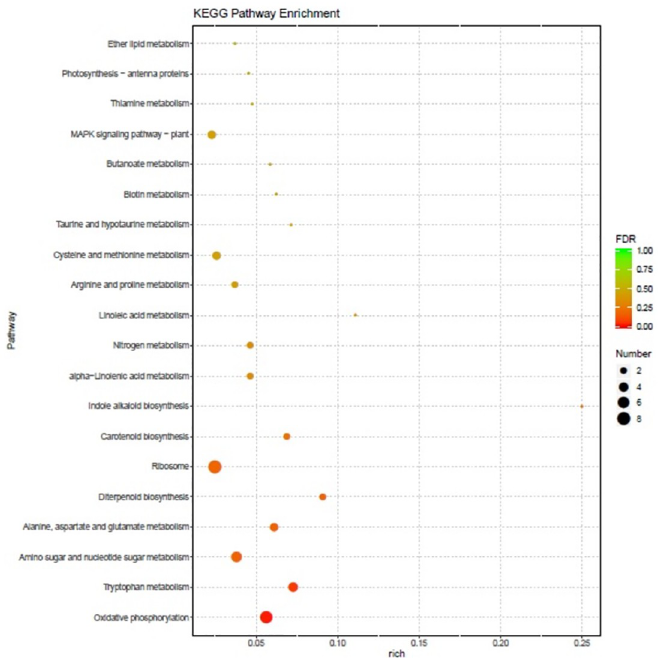
Fig 6. KEGG pathway analysis of differentially expressed genes during the B . aryabhattai -Arabidopsis interaction. The chart shows the enrichment of signaling pathways with differentially expressed genes. The Y-axis label represents the pathway, and the X-axis label represents the rich factor (rich factor = number of differentially expressed genes enriched in the pathway/number of genes in the background gene set). The size and color of the bubble represent the number of differentially expressed genes enriched in the pathway and the enrichment significance, respectively.